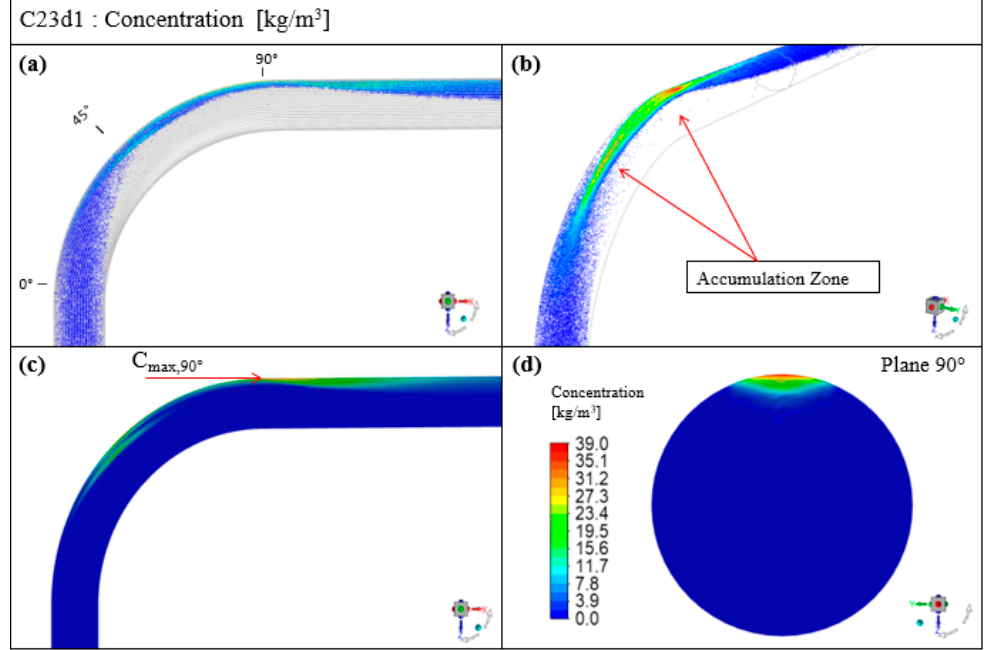
Figure A6. Results of particle concentration. Case C23d1. ( a ) Instant positioning of the X-Z plane particles ( b ) Instant positioning of the particles in 3D view ( c ) Concentration contour in the X-Z plane of the mid-section of the pipe ( d ) Concentration contour in the Z-Y plane of the maximum concentration cross section. Snapshots are taken for a statistically steady flow.